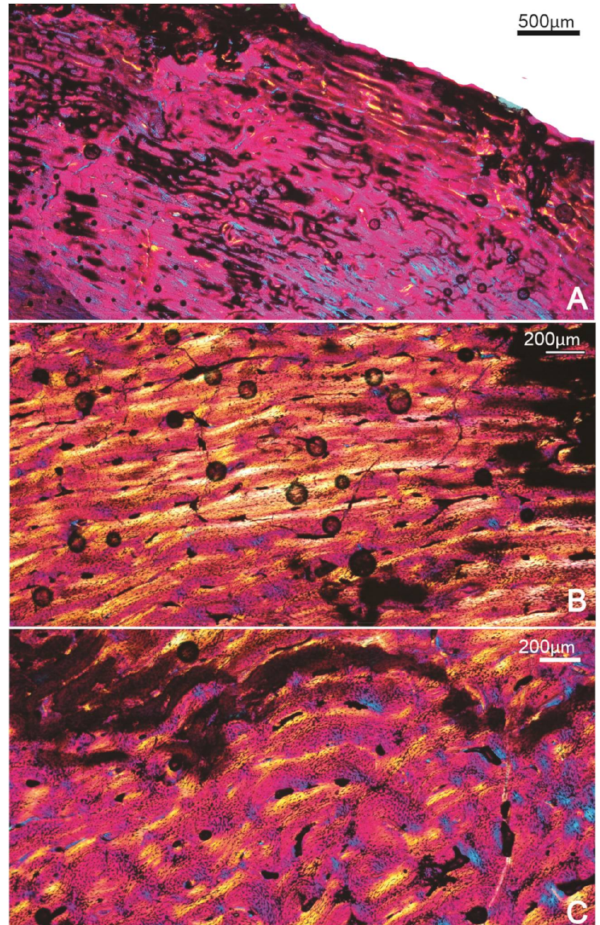
Figure 2. Specimen FU2759; tibiotarsus. ( A ) Outermost region of the compacta showing some diagenetic features but no change in the rate of bone formation, and vascular canals right up to the edge of the bone wall. ( B ) Mid-cortical region showing the circumferential organisation of the vascular canals. ( C ) Deep cortex of the compacta showing the more haphazard arrangement of the vascular canals within a woven bone